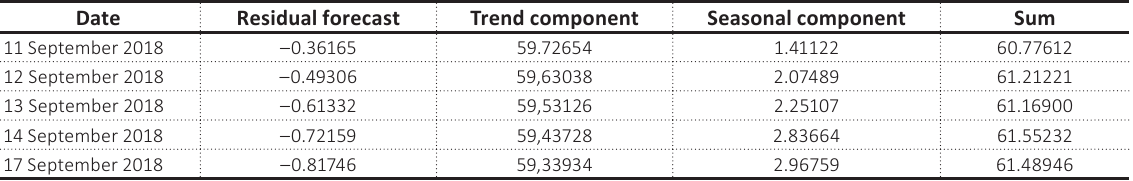
Table 2. Aurubis stock